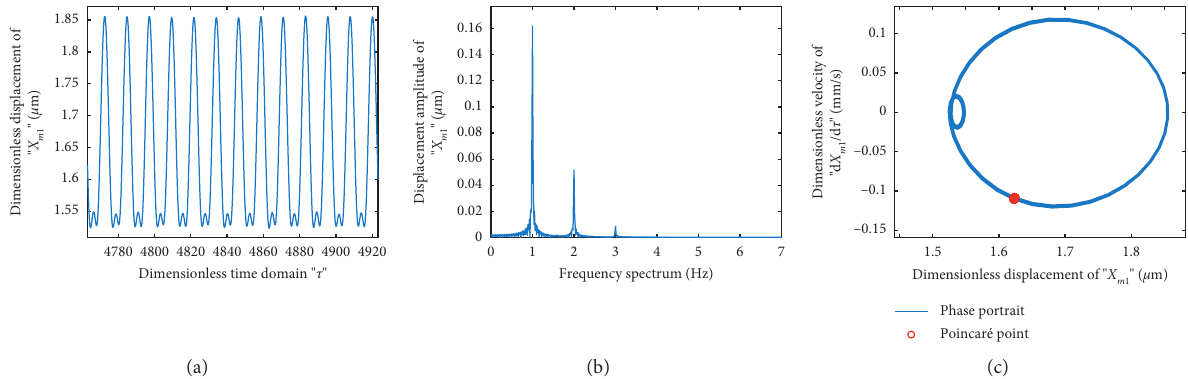
� s � 40 μ m. (a) X 1 2